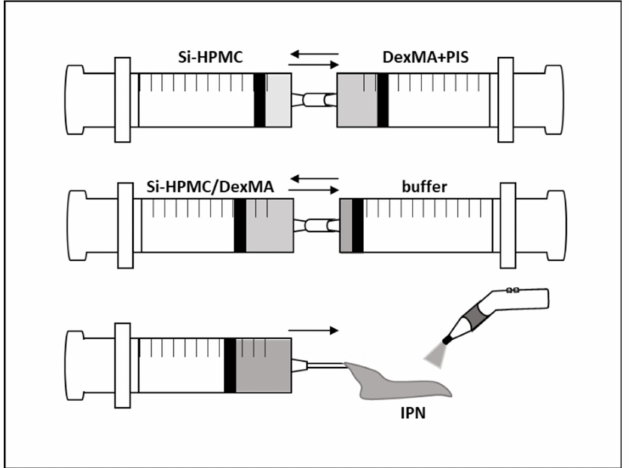
Figure 1. Preparation and photo-crosslinking of IPN. First, solutions of Si-HPMC and DexMA containing the PIS were mixed together using two syringes connected with a Luer lock. The acidic buffer was then added to the mixture using another syringe connected with a Luer lock. The IPN solution was then ready to be injected and photo-crosslinked (420–480 nm). Si-HPMC: silanized hydroxypropyl methylcellulose, DexMA: dextran methacrylate, PIS: photoinitiator solution, IPN: interpenetrating polymer